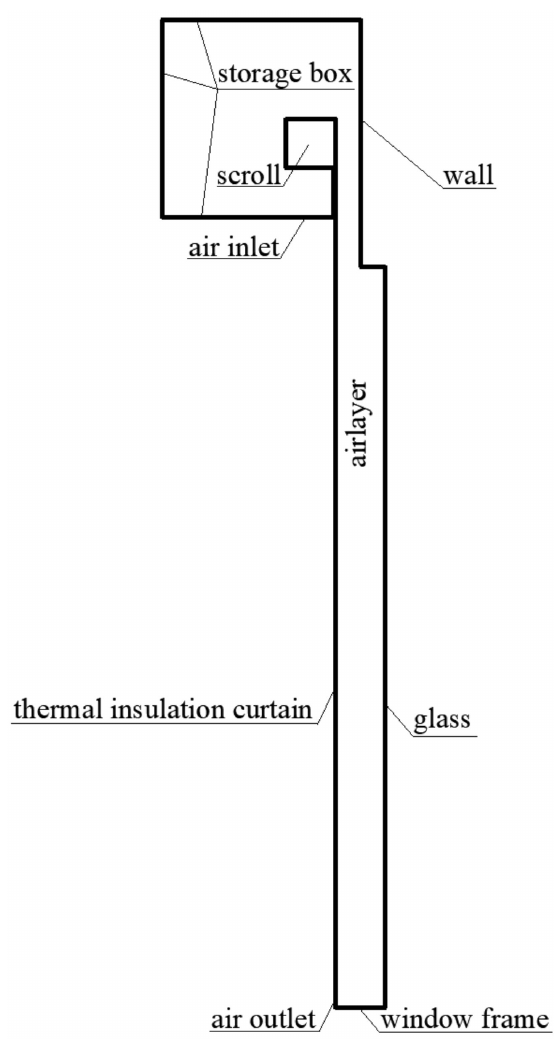
Figure 2. Model figure. Meteorological parameters of Taiyuan city, China, were selected in Fluent to simulate the indoor temperature of the room model. Boundary conditions are shown in Table